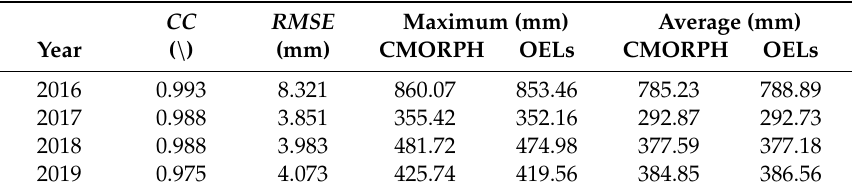
Figure 9. The accumulated rainfall from Climate Prediction Center morphing method (CMORPH) and OELs network during plum rain season (June, July) of 2016, 2017, 2018 and 2019 in Jiangning district of Nanjing. Table 5. The evaluation metrics of accumulated rainfall field from OELs network during plum rain season (June, July) of 2016, 2017, 2018 and 2019 in Jiangning district of